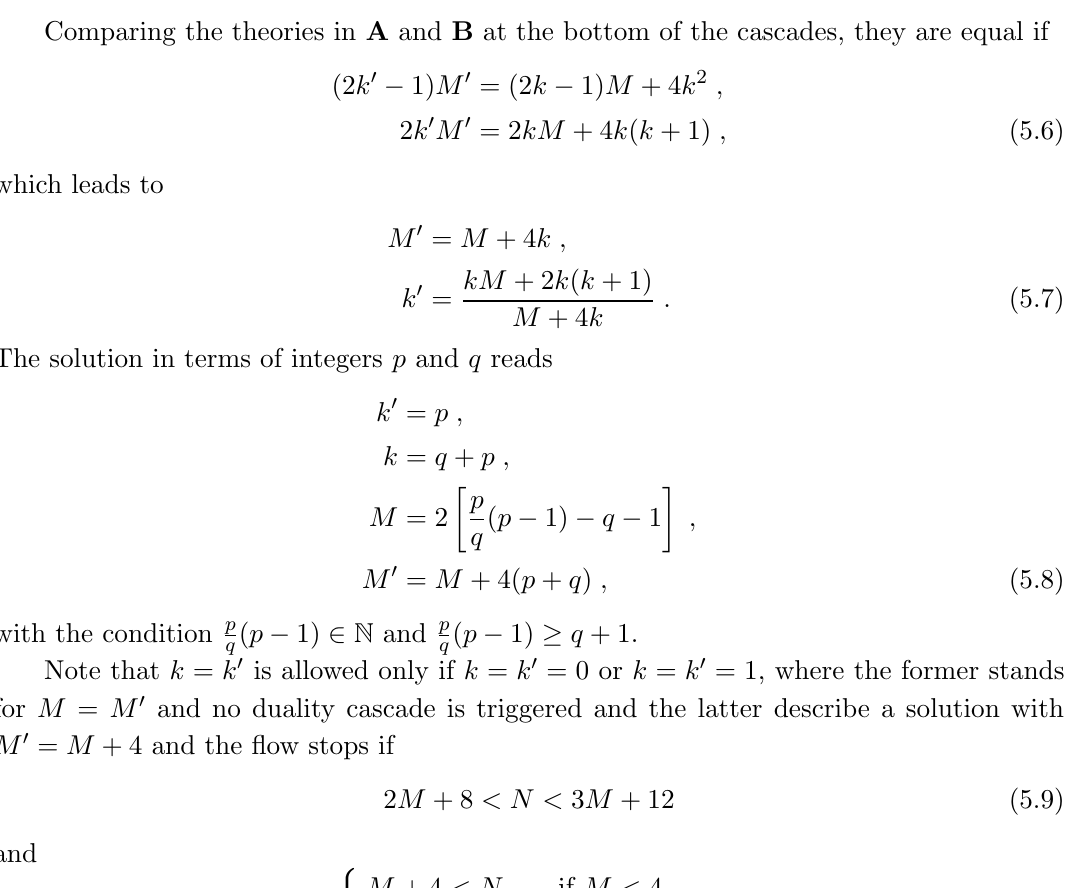
. The orientifold 2